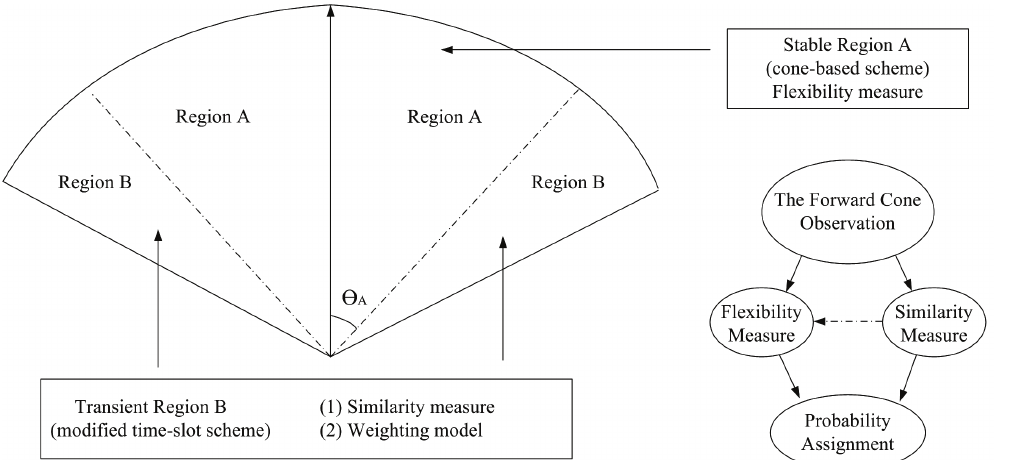
Figure 9. The probabilistic model of the proposed HDTC